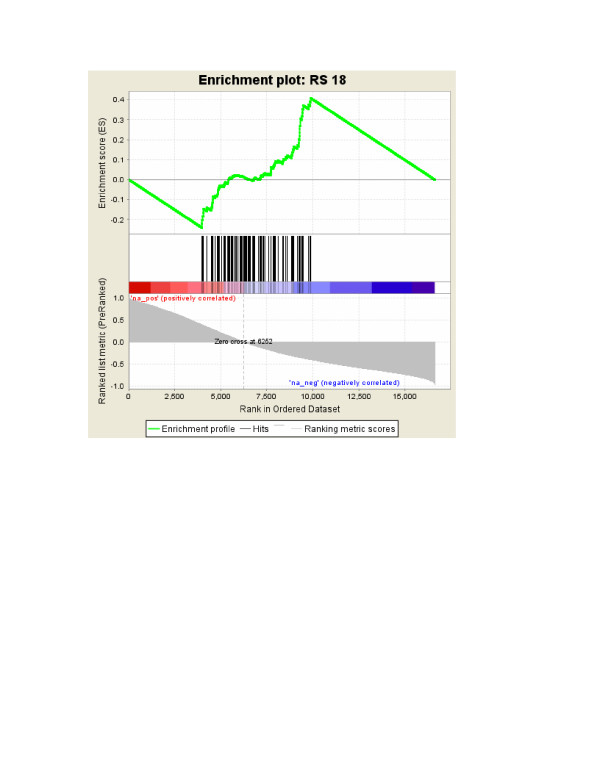
A statistically significant GSEA result. An illustration of a statistically-significant GSEA result with 100 genes selected at random from genes with no or weak correlation of expression with the phenotype (|r| < 0.4).